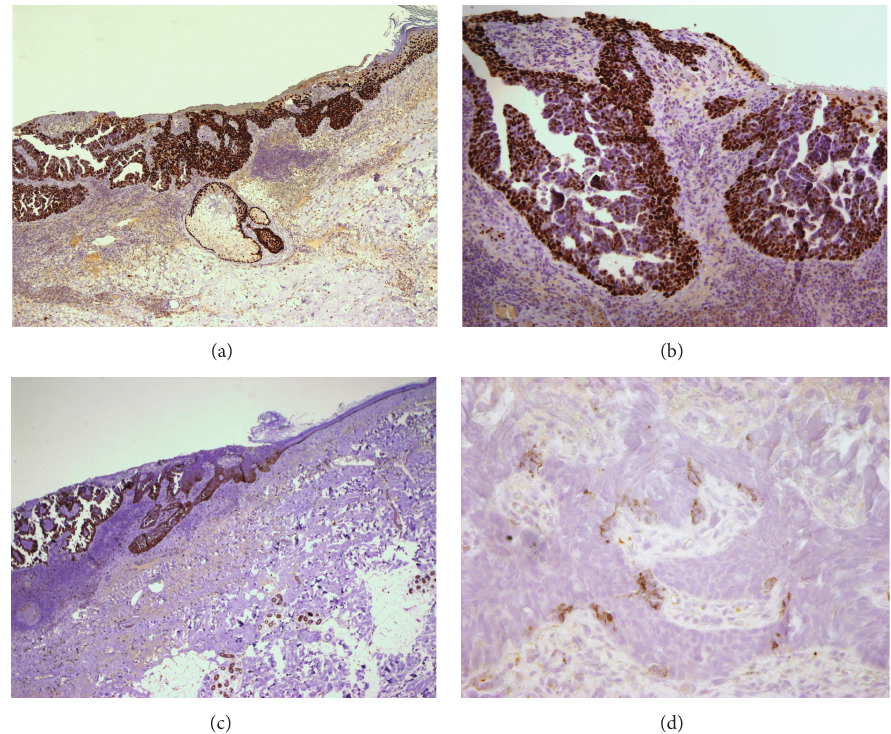
Figure 2: Analysis of a skin syringocystadenocarcinoma papilliferum specimen. (a) p63 antibody stains the transition area from epidermis epithelium to the squamous neoplasm and the basal layer of glandular component (original magnification × 40). (b) The papillary structures are moderately positive and/or negative for p63 (original magnification × 100). (c) Immunohistochemical staining demonstrates c-kit at the basal layer of neoplastic budding; almost negative, only with speckled positive cells, is the squamous solid component (original magnification × 20). (d) A few positive cells of the squamous neoplasia are stained by Nestin antibody, stemness marker (original magnification ×